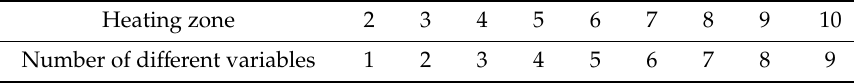
Table 1. The number of di ff erent variables in the remaining zones and zone 1.